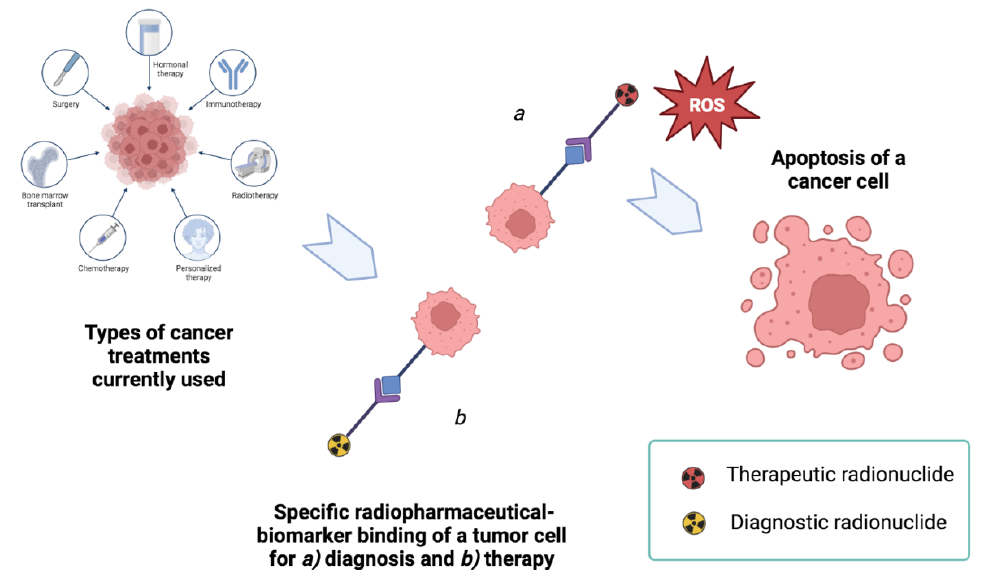
Figure 1. The concept of radiotheranostics within the framework of treatments used in case of cancer disease. In this case, the objective of the research is to develop pharmaceutical formulations that keep the radionuclide component unchanged, but adapt the ligand component according to its (a) diagnostic or (b) therapeutic purpose.